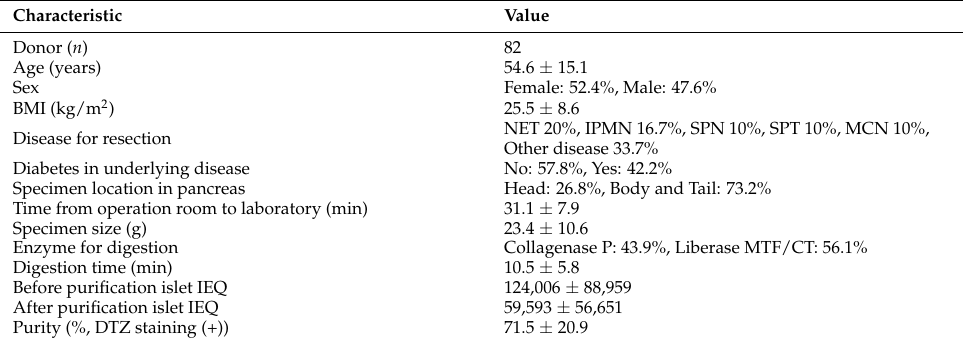
Table 1. Donor characteristics and outcomes of islet